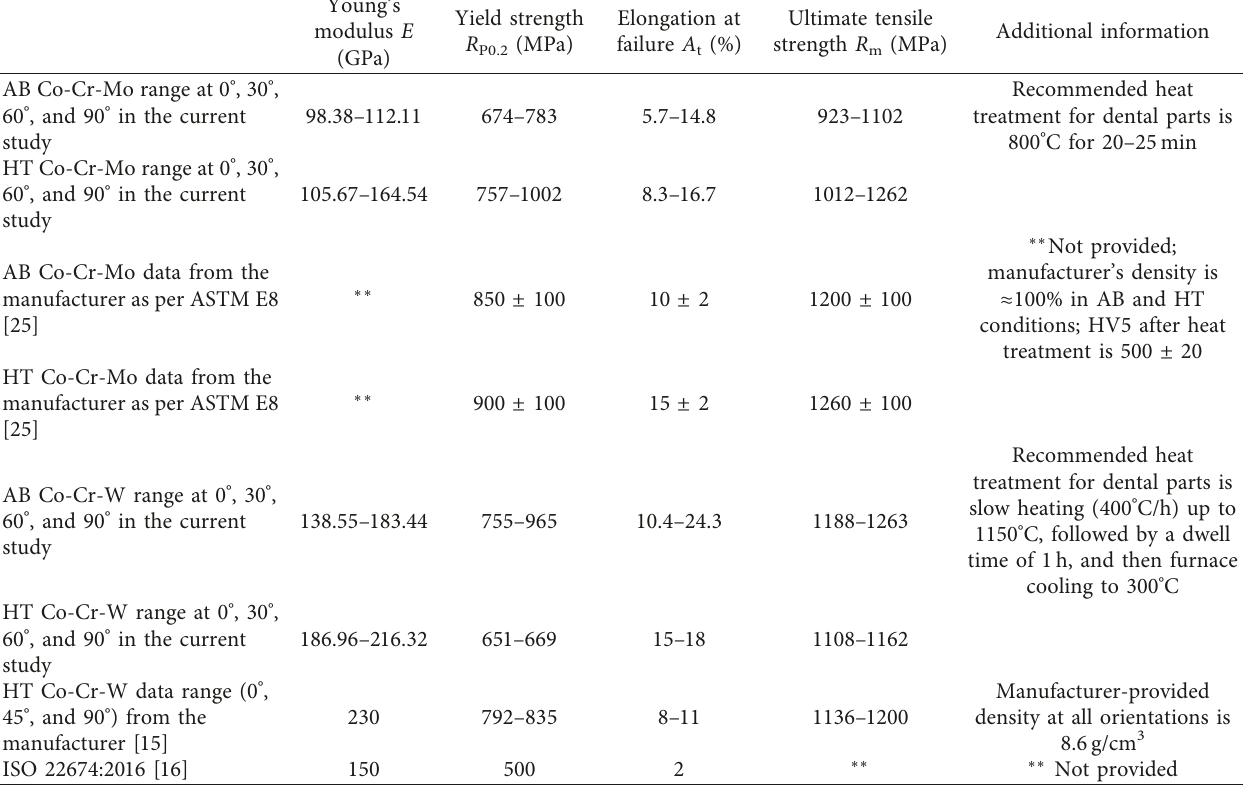
Table 2: Tensile properties of alloys in comparison to standards requirements.